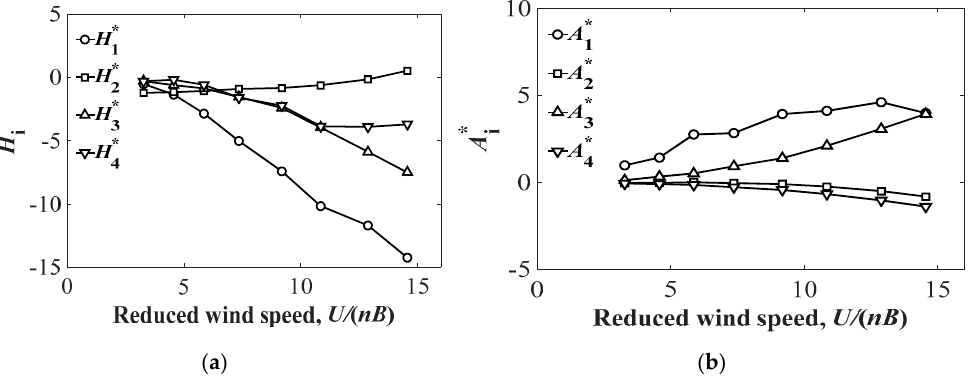
∗ flutter derivatives ( b ) 1...4